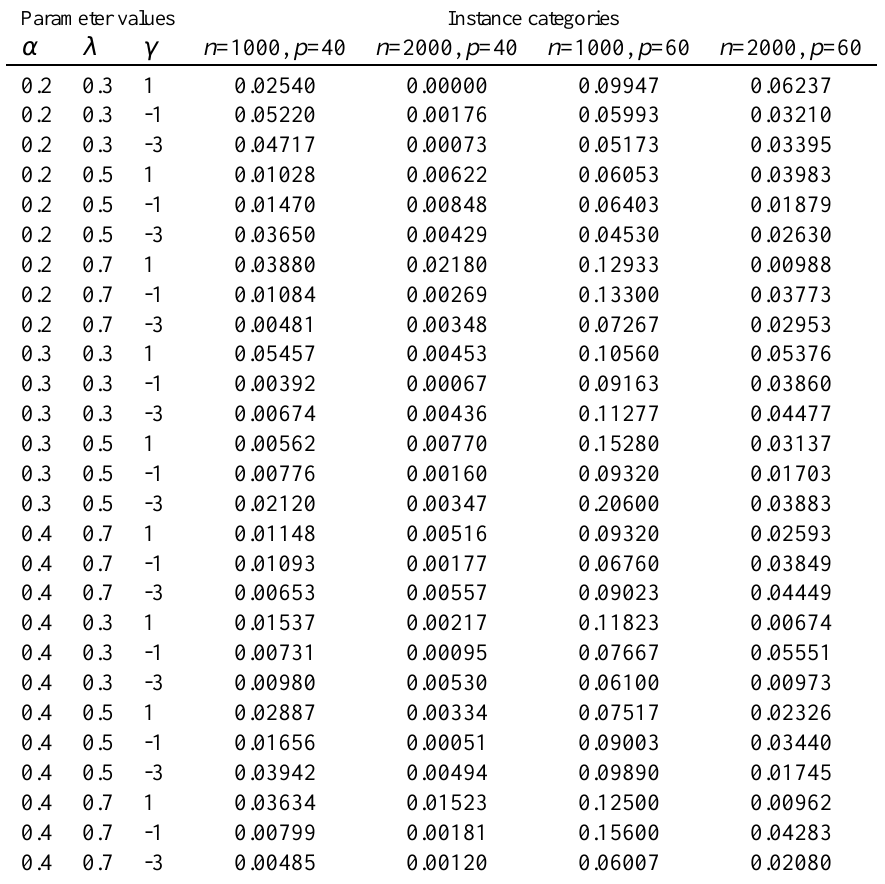
Table 2. Average results for infeasibility values for each